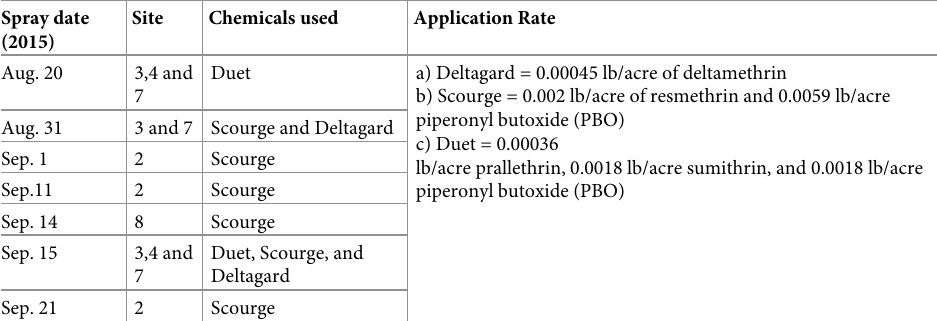
Table 1. Spray history at treated